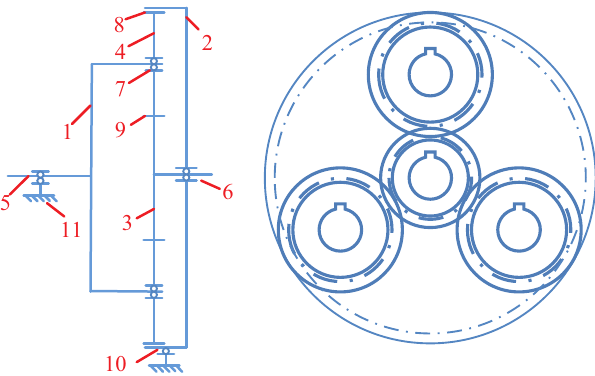
Figure 1. Structure diagram of a planetary gear stage, where 1 represents the carrier, 2 represents the ring, 3 represents the sun, 4 represents one planet, 5 represents the carrier bearing, 6 represents the sun bearing, 7 represents the planet bearing, 8 represents the inner mesh between the ring and the planet, 9 represents the outer mesh between the sun and the planet, 10 represents the ring bearing and 11 represents the